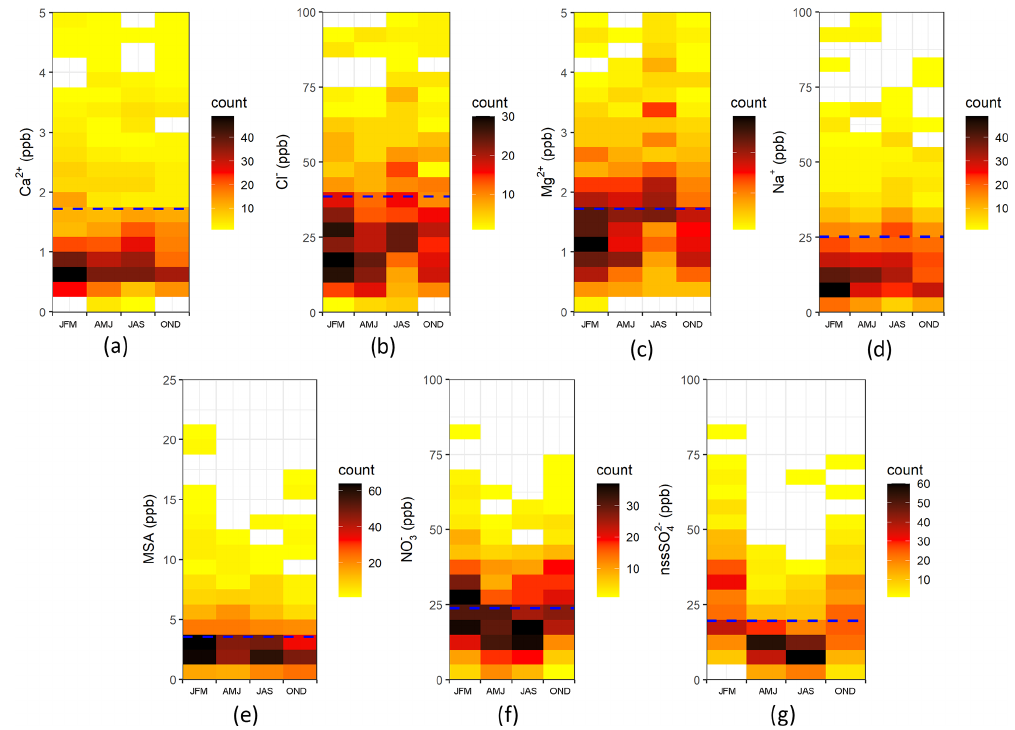
− (f) and NO − (g) concentrations in the GV7(B) 4 3